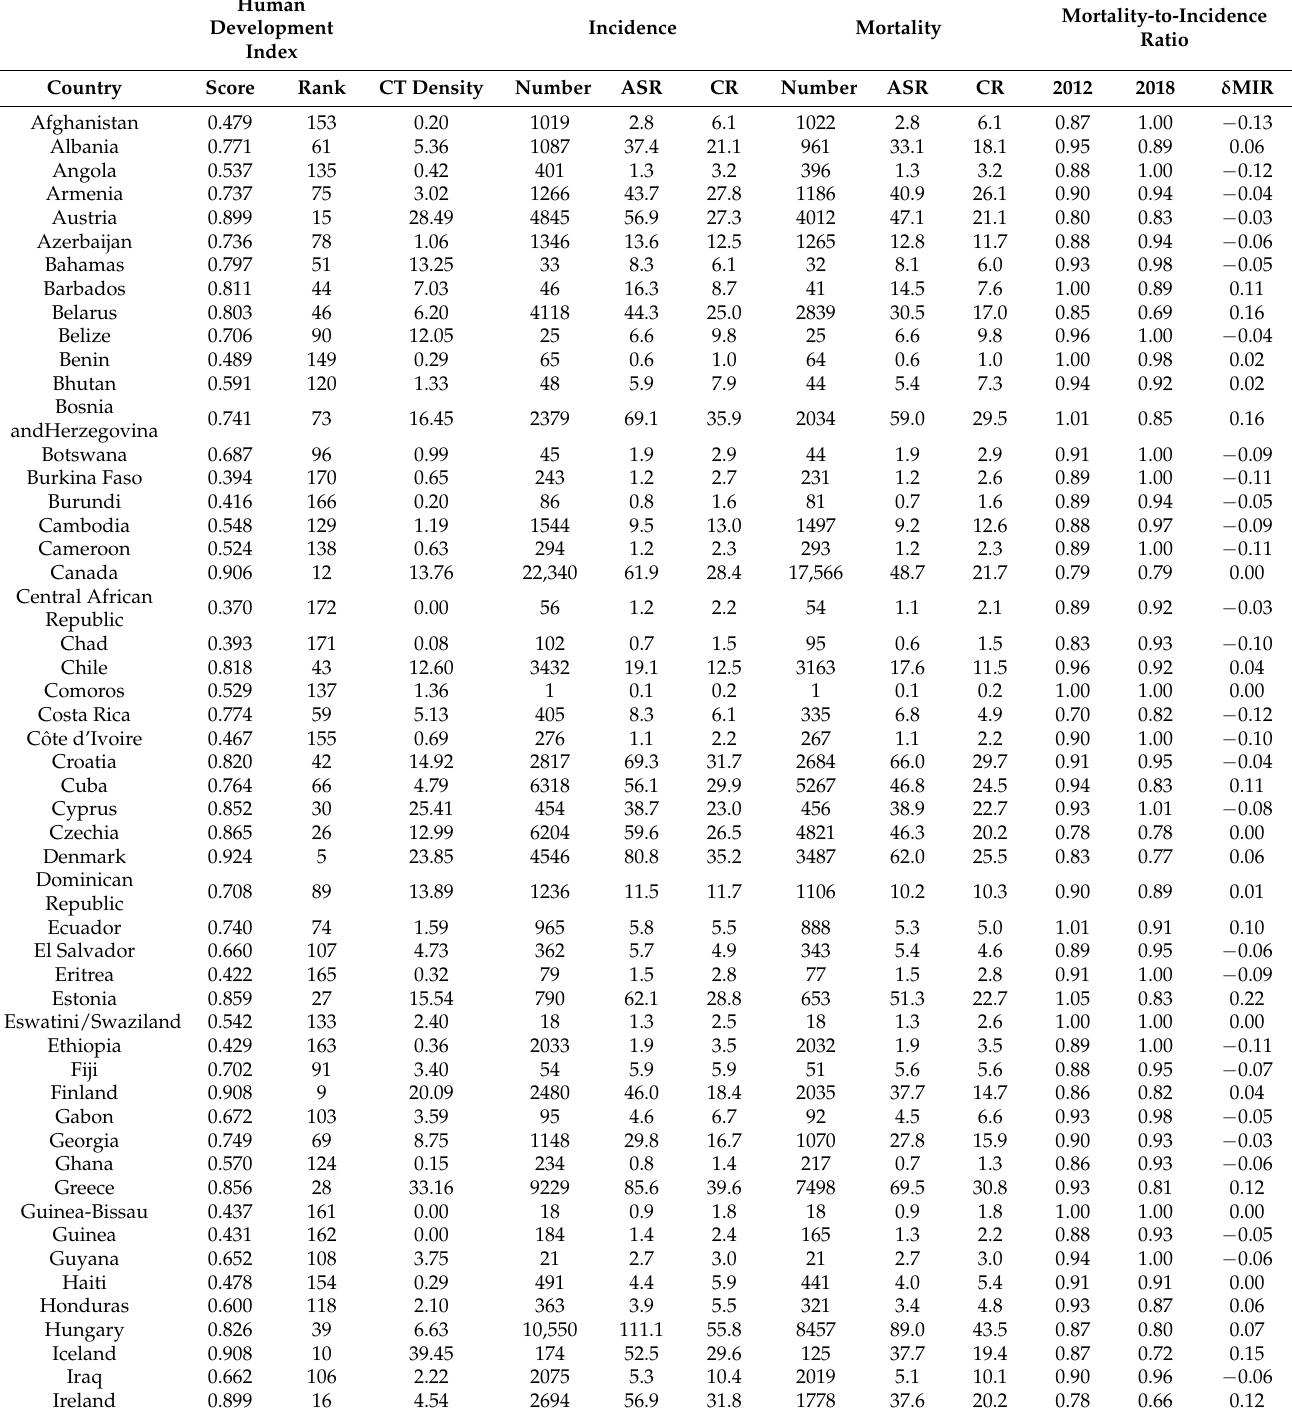
Table 1. Summary of human development index, CT density, cancer incidence, cancer mortality, and mortality-to-incidence ratio for lung cancer in selected